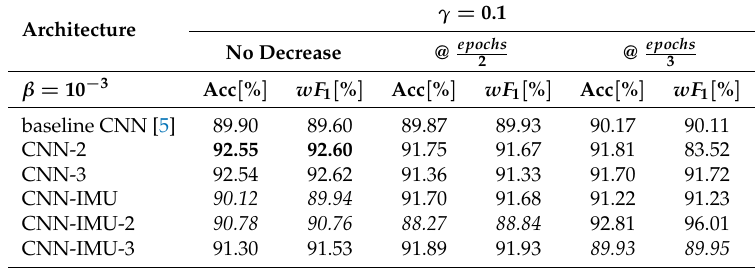
Table 11. Validation accuracies and Weighted F1 for the architectures on the Pamap2 dataset when reductions of the learning rate during training are